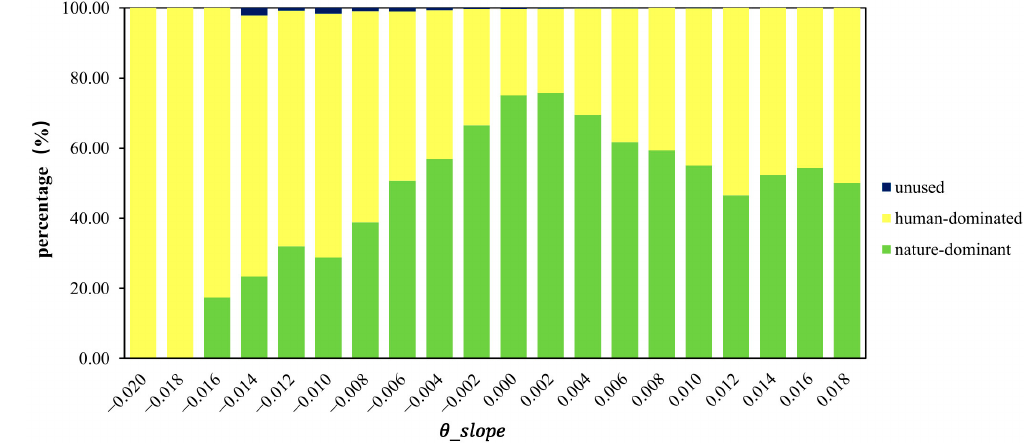
Figure 13. 𝜃 (cid:3046)(cid:3039)(cid:3042)(cid:3043)(cid:3032) of the annual NDVI for different land use